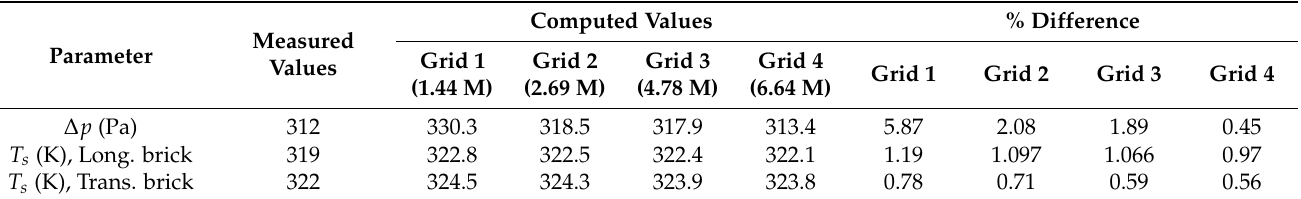
Table 1. Effects of the grid size on the computed pressure drop ( ∆ P ) and surface temperatures ( T s ) of longitudinal and transverse bricks (using the k- ω turbulence model) for the HDS.